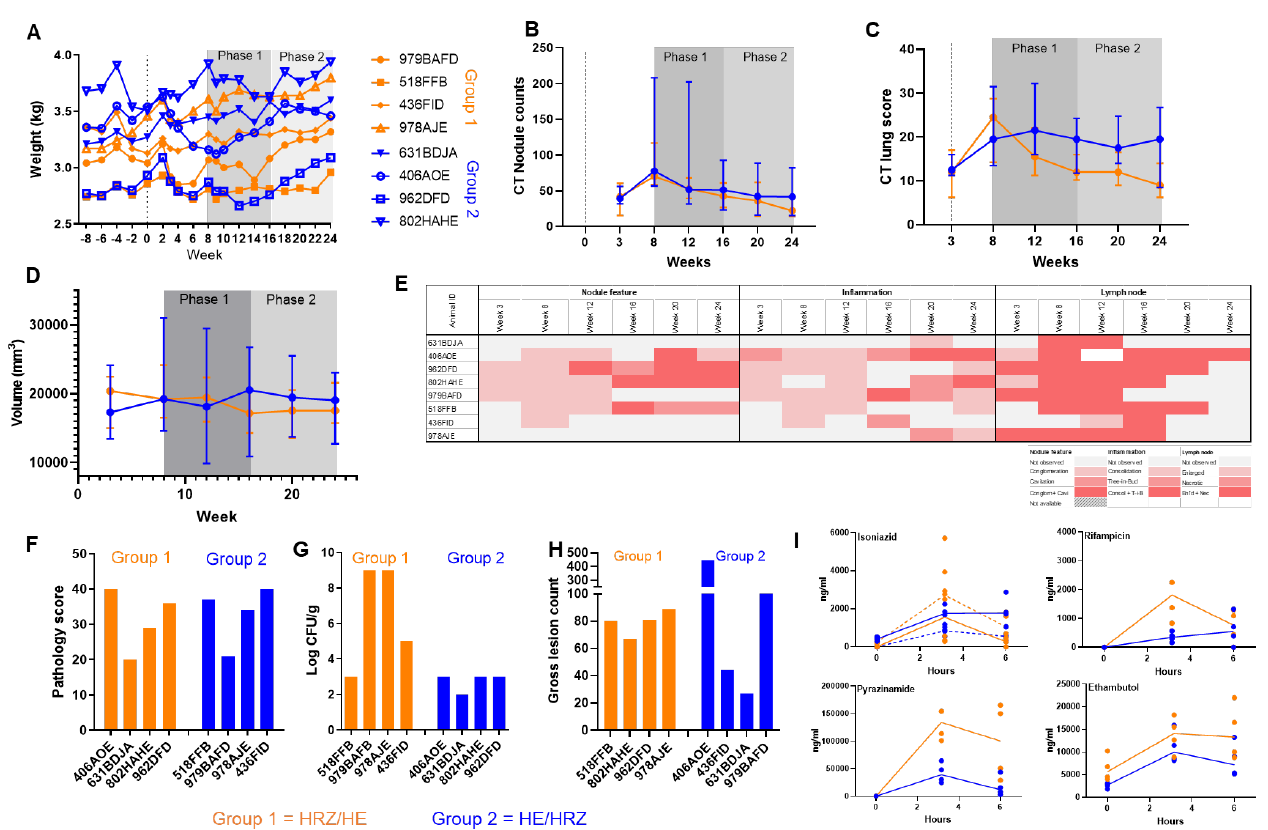
Figure 5. Measures of M. tb induced disease burden and drug exposure levels in blood in cynomolgus macaques following infection with M. tb Erdman and two phases of treatment with combinations of HRZ or HE. ( A ) Body weight profiles, ( B ) nodule counts measured from CT scans, ( C ) lung score measured by CT, ( D ) volume of diseased lung as measured by CT scan, ( E ) heatmap of disease characteristics as measured by CT scan, ( F ) gross pathology scores, ( G ) M. tb bacillary burden, ( H ) granuloma types assessed by histopathology by presence in different lung lobes, ( I ) levels of Rifampicin, Isoniazid, Pyrazinamide and Ethambutol detected in blood samples 3.15 and 6 h after administration. Orange = Group 1 (HRZ/HE), blue = Group 2 (HE/HRZ), Medians shown. ng/mL. Isoniazid was measured in both treatment phases so complete line = phase 1, dashed line = phase 2.